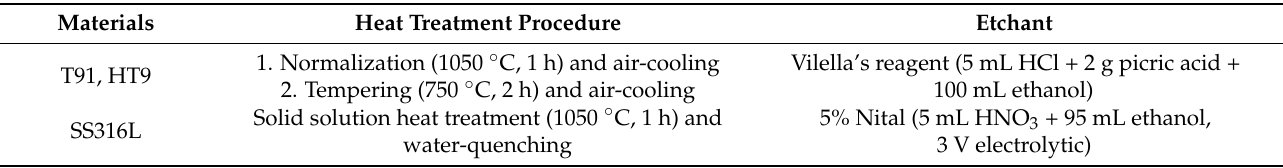
Table 2. Heat treatment and etching conditions of tested materials.